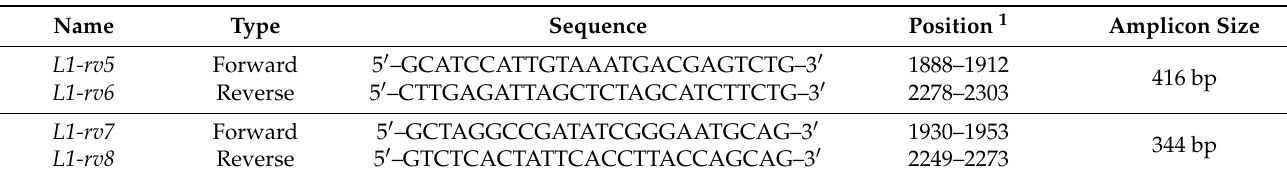
Table 1. Primers used for PCR